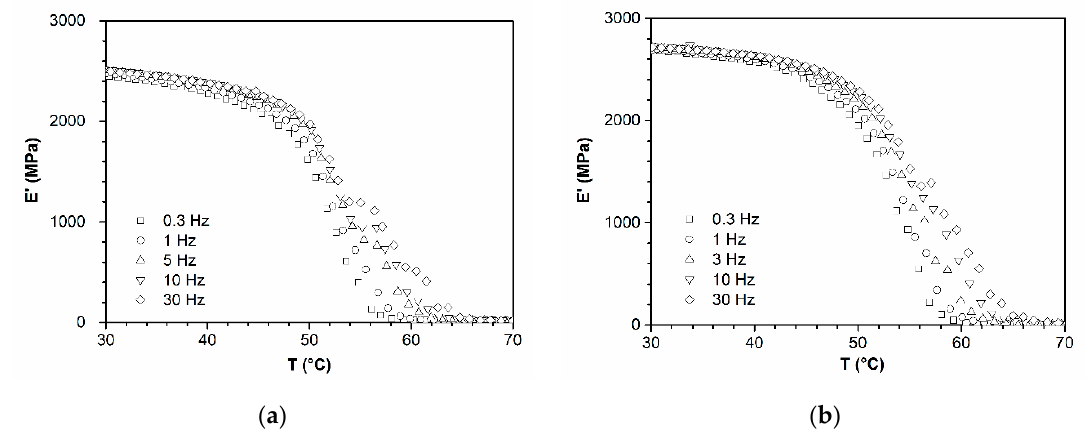
Figure 8. Storage modulus in multifrequency DMTA analysis of ( a ) PLA and ( b ) PLA-Ar805-8 nanocomposite at various frequencies in the range 0.3–30 Hz (heating rate of 0.5 °C/min).